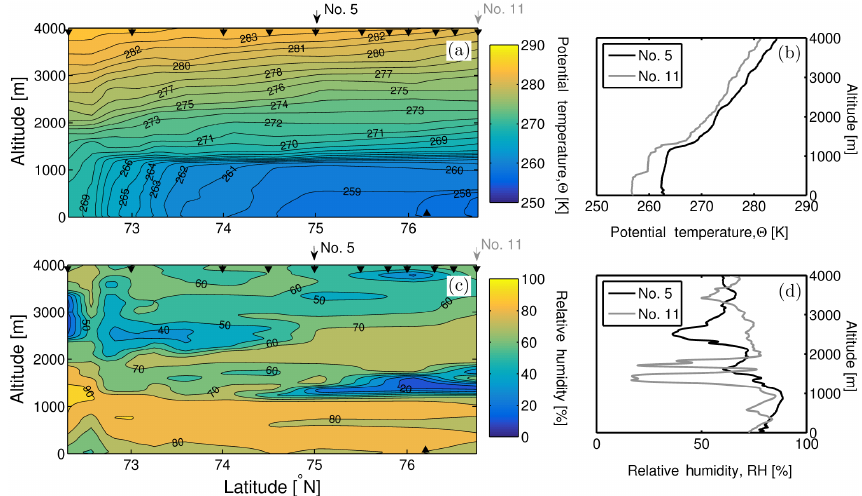
Figure 3. Contour figures of potential temperature ( (cid:50) , a ) and relative humidity (RH, c ) using data from the 11 dropsondes released on approach to Longyearbyen, Svalbard. Dropsonde release locations (downward-facing triangles) and the approximate sea ice edge (upward- facing triangle) are marked. Profiles of (cid:50) (b) and RH (d) from dropsondes nos. 5 and 11 are also shown due to their comparable latitudes to the in situ observations (see Table 1). The positions of these dropsondes relative to the others are indicated above panels (a, c) .